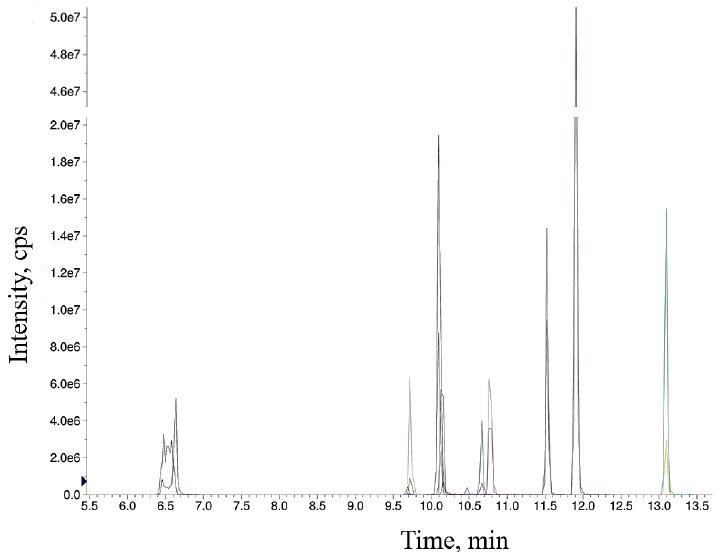
Figure 2. Chromatogram of a mixture of standards with a concentration of 0.50 mg/L.